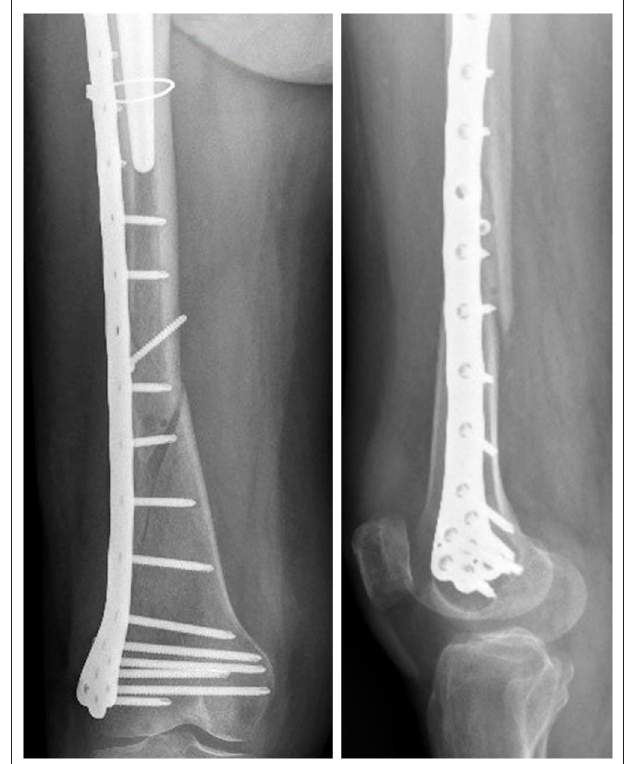
FIGURE 2 | Anteroposterior (Left) and lateral (Right) x-ray images of the reduced periprosthetic fracture after the plate